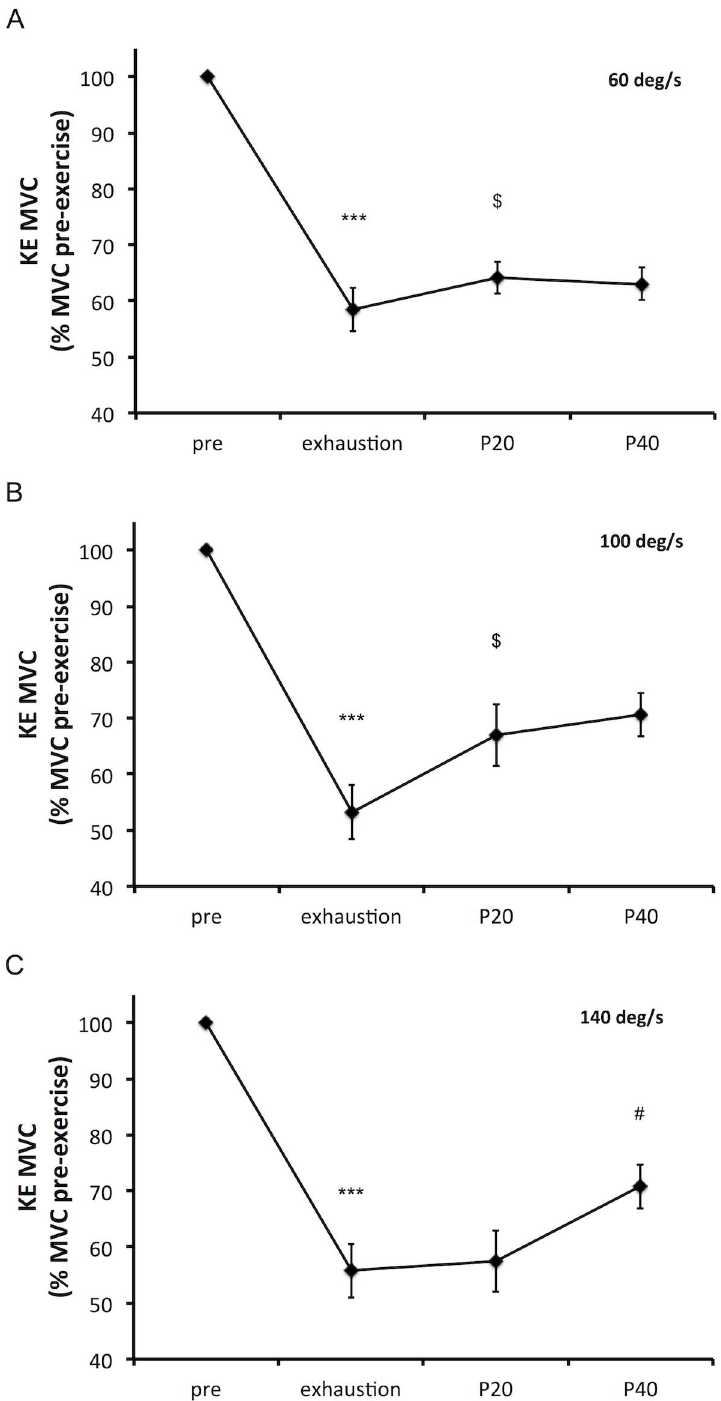
Fig 6. Changes in isokinetic knee extensors maximal voluntary contraction (KE MVC) following the time to exhaustion tests (85% peak power output) and their recovery. Isokinetic KE MVCs were performed at 60 (panel, A), 100 (panel B) and 140 (panel C) deg/s. Isokinetic KE MVCs were measuredpre- exercise (pre, average of all three sessions pre-exercise values), shortly after exhaustion (13 ± 4 s after exhaustion), 20 s followingexhaustion test (P20) and 40 s followingexhaustion test (P40). Data are presented as mean (SE). * significantlydifferent from pre, $ significantly different from exhaustionand # significantly different from P20, 1 item for P < 0.05 and 3 items for P <